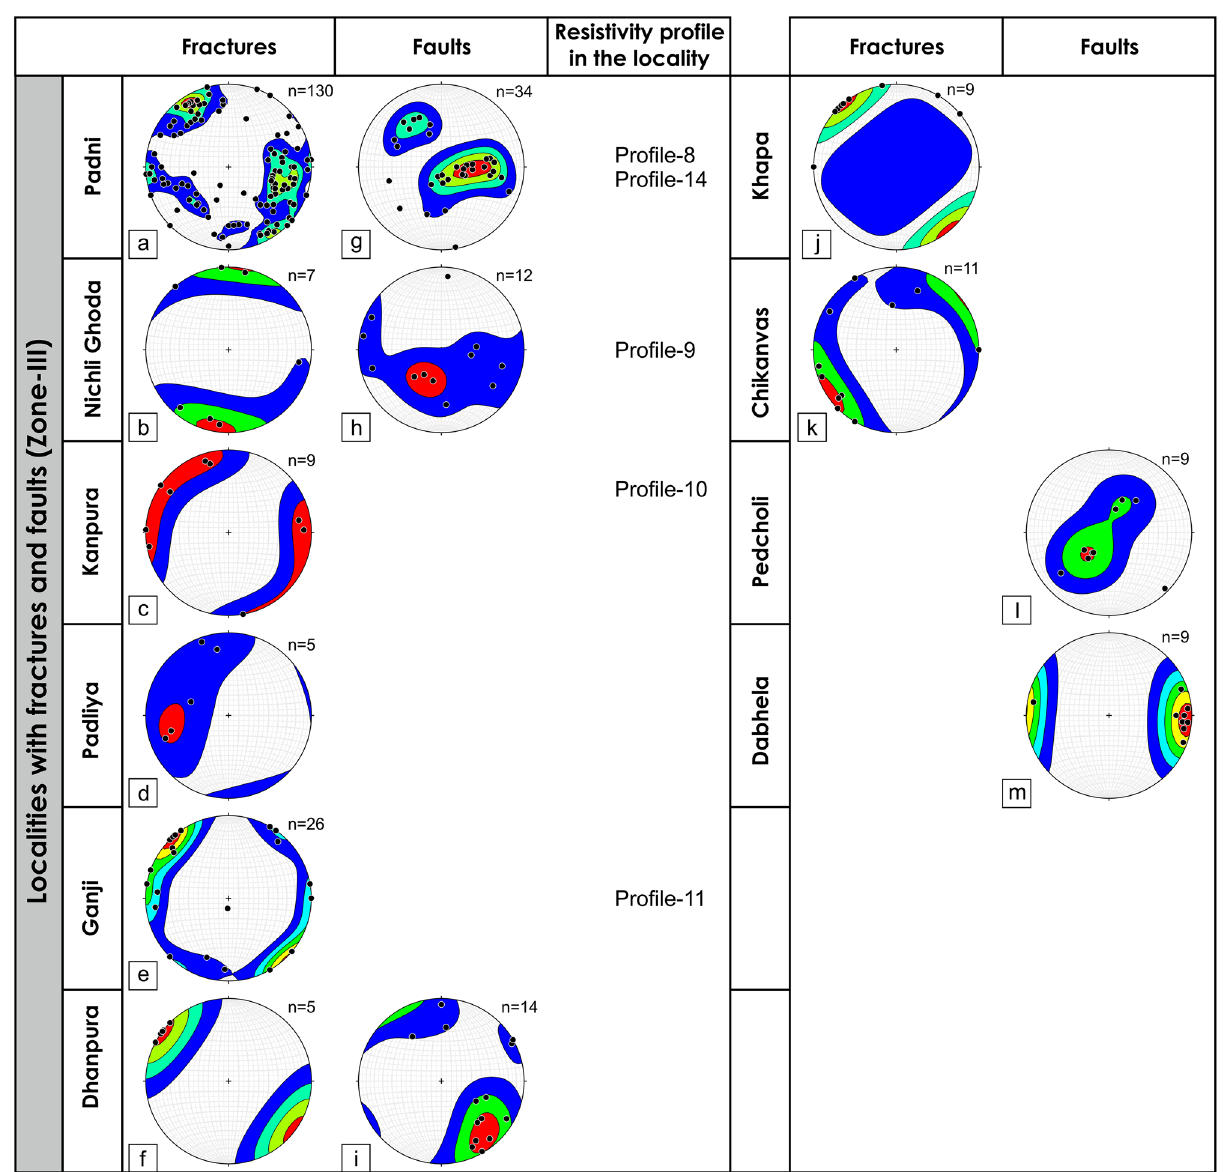
Figure 9. Poles to the fractures and faults for different localities from Zone-III are plotted in the lower hemisphere stereographic projection along with the resistivity profile number in the locality. ( a – f,j,k ) Lower hemisphere projection of poles to the fractures from different localities, ( g–i,l,m ) Lower hemisphere projection of poles to the fault surface collected from different